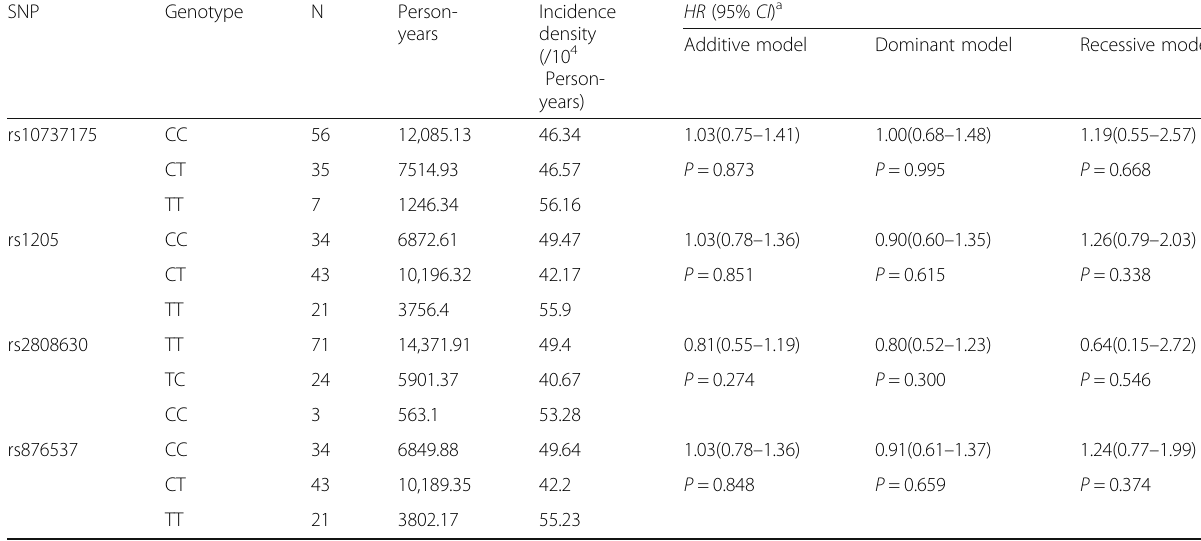
Table 2 Association analysis of CRP polymorphisms with CHD